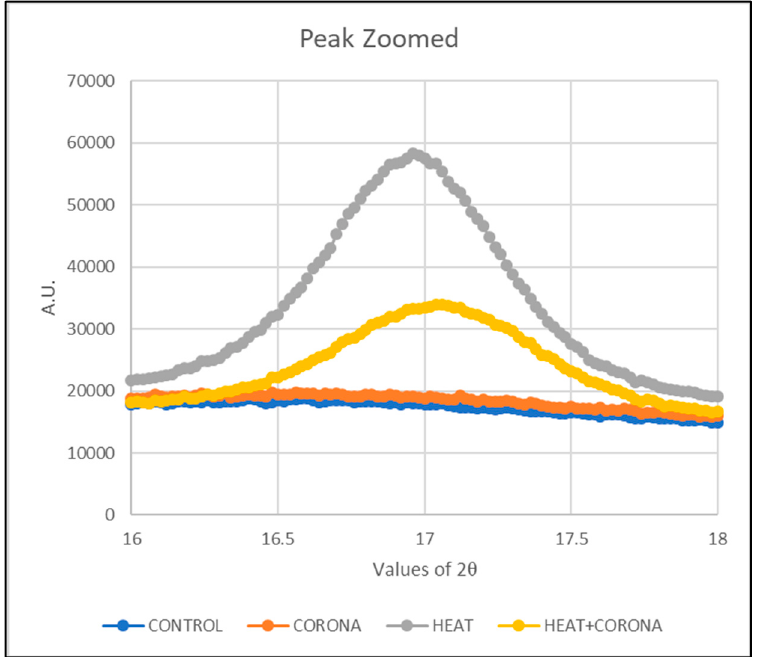
Figure 9. Zoomed in α -phase peak at 16.96° of PVDF nanofibers .